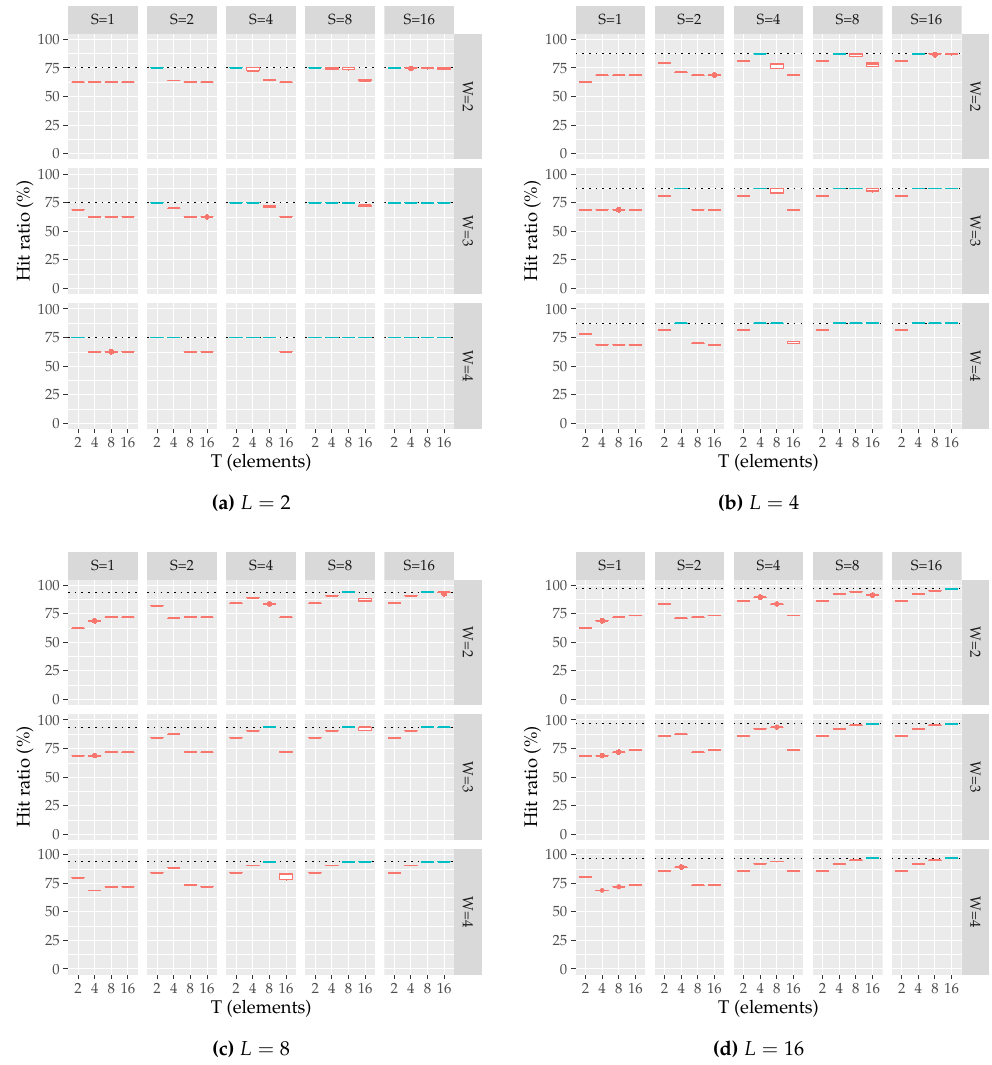
Figure 7. Plots (a, b, c, d) show data cache hit ratios varying the number of elements per line ( L = 2,4,8,16 elements) for different cache configurations with S sets, W ways, and tile sizes of T elements. Each boxplot gathers the results of all matrices from 1024 Boxplot color shows whether the ideal hit ratio is always reached (green) or not (orange).